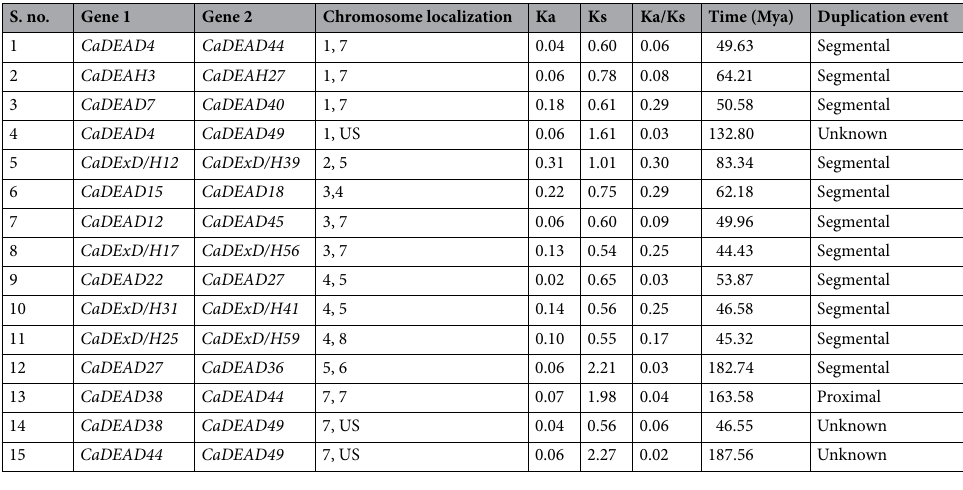
Table 1. Paralogous gene pairs for the RNA helicase gene family identified in chickpea. US unplaced scaffolds, Ka nonsynonymous substitutions per nonsynonymous site, Ks synonymous substitutions per synonymous site, T approximate time (Mya; million years ago) of the duplication